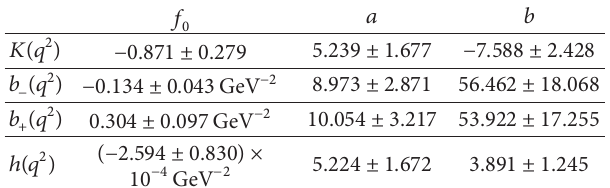
Figure 6: The same as Figure 3 but for 𝑏 − (𝑞 2 ) . Table 1: Parameters appearing in the fit function of the form